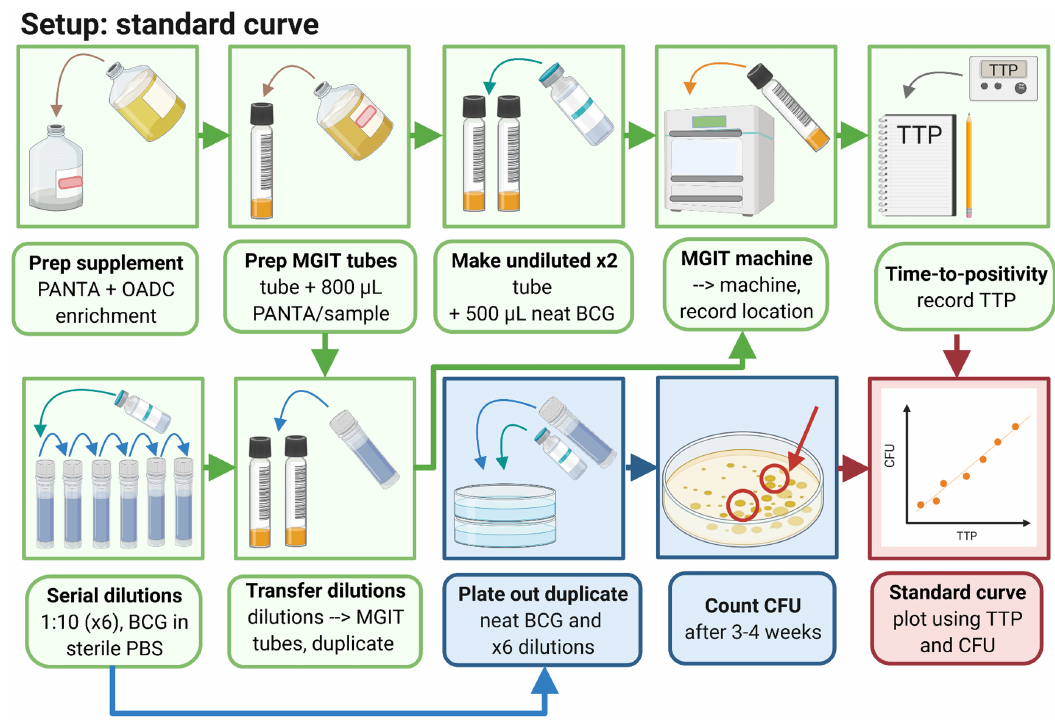
Figure 2. Generation of a stock standard curve (created with BioRender.com).